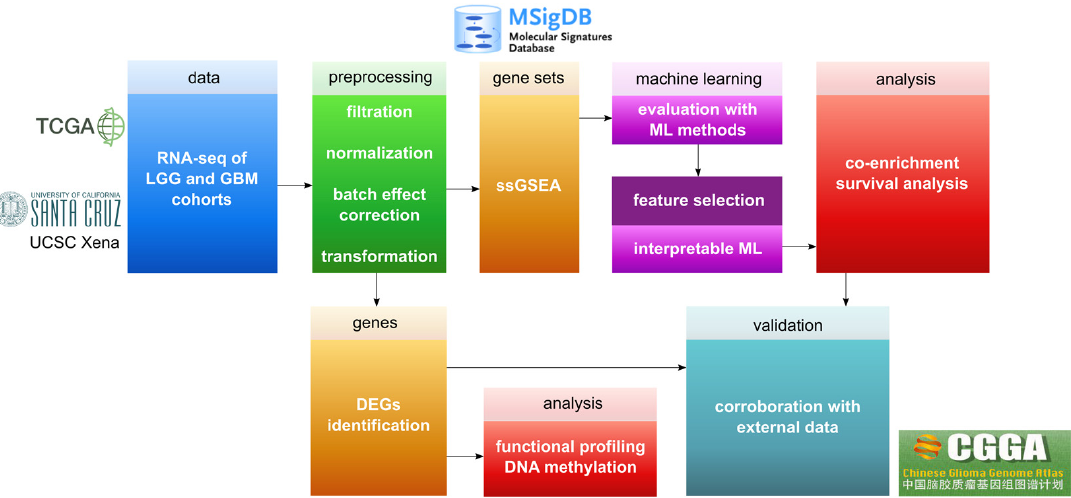
Figure 1. Overview of the pipeline applied in this work. Following preprocessing were two separate analyses: The lower tier of the pipeline illustrates the steps employed for identification and basic analysis of DEGs, while the upper tier demonstrates the steps for ssGSEA analysis based on ML approaches using MSigDB collections. The final step illustrates the validation of the results.